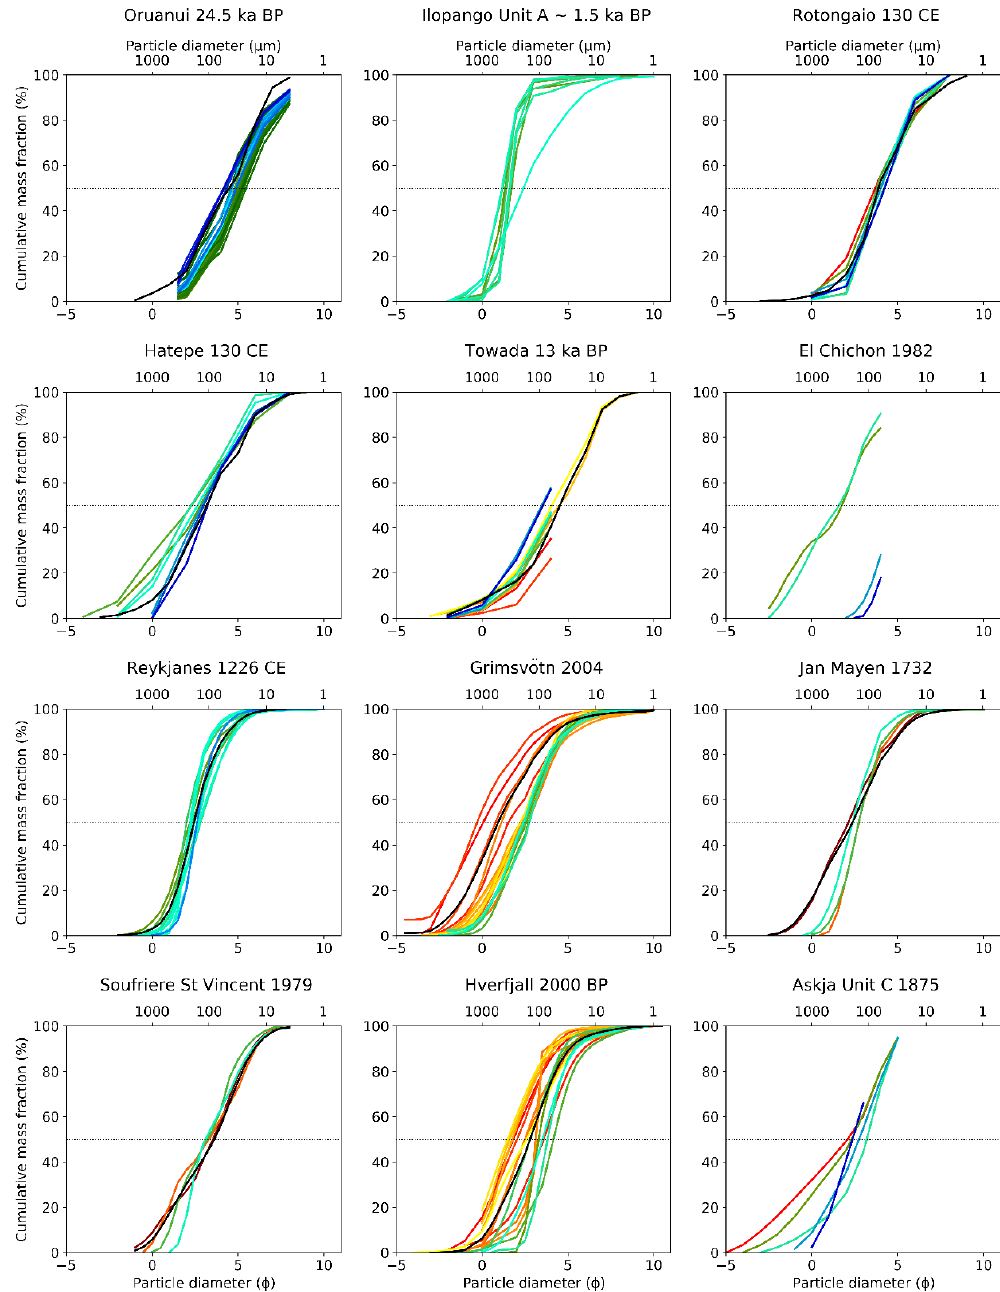
Figure 4. Hydromagmatic total grain size distributions (TGSDs) and particle size distributions (PSDs) at varying distance from source. Colours indicate distance of PSD from source: < 10 km red/yellow; 10–50 km greens; > 50 km blues. TGSDs are in black. Dotted line shows the median grain size (i.e., 50% mass fraction). PSDs for Towada and El Chichón are only for grain size ≤ 4 Φ. TGSD for Ilopango Unit A [43] was not included as it seems inconsistent (too coarse) with grain size data from the individual sites.